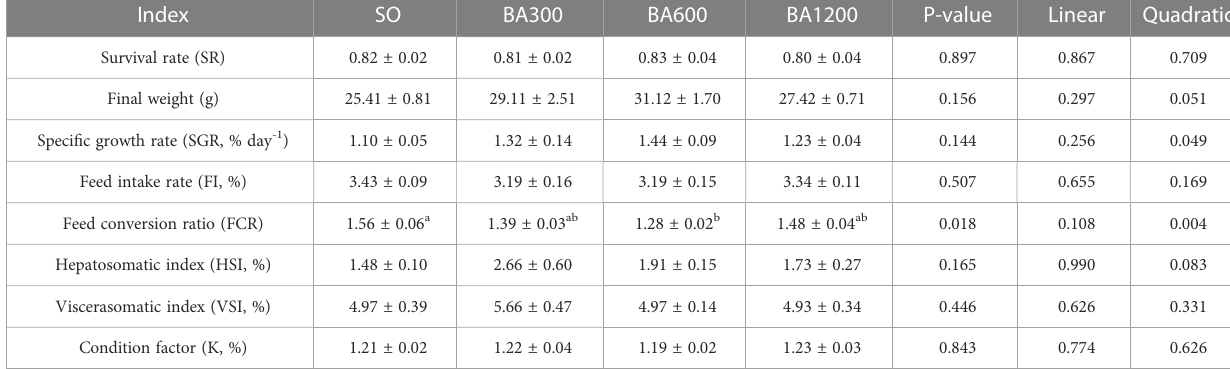
TABLE 3 Survival, growth performance and body index of juvenile large yellow croaker in different treatments (Means ± SEM, n = 3) 1